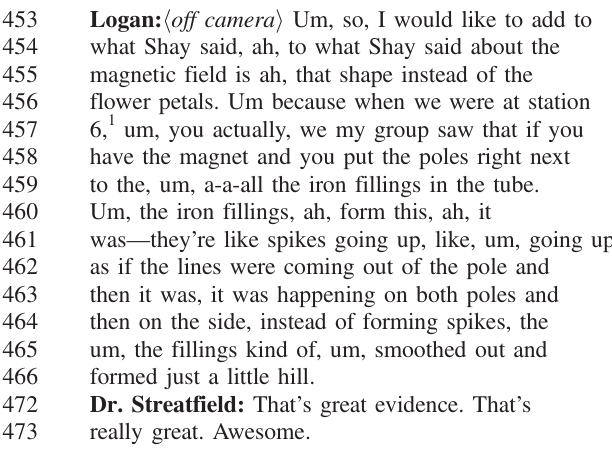
FIG. 2. This model shows three positions of the magnet and paperclip, touching (top, point A), nearby within the magnetic field, but not touching (middle, point B), and outside of the magnetic field (bottom, point C). In each image the magnetic field is drawn with concentric circles surrounding the magnet (e.g., point D) and the small entities inside the magnet are referred to as “ molecules ” as represented by small circles, some of which have arrows (point E). The north pole is represented by “ up ” arrows and the south pole by “ down ” arrows. In the instance when the paperclip is touching, all molecules are magnetic. When the paperclip is nearby but not touching, some of the molecules are magnetic, and when far away the molecules are not